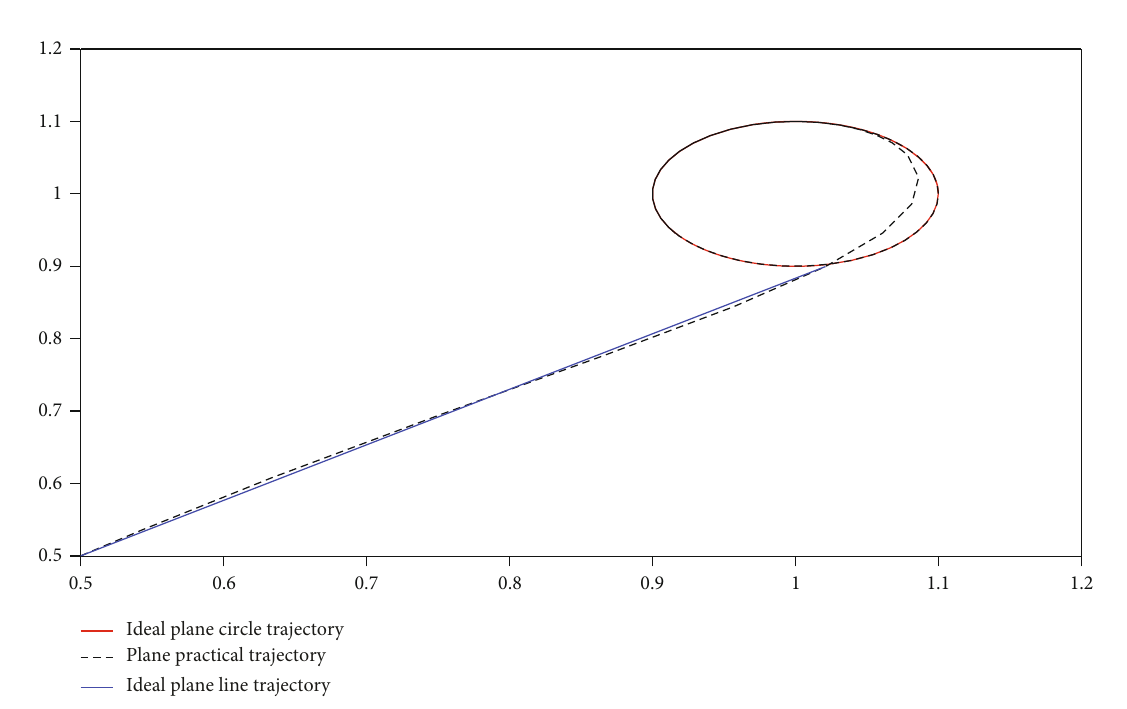
Figure 15: Path tracking in